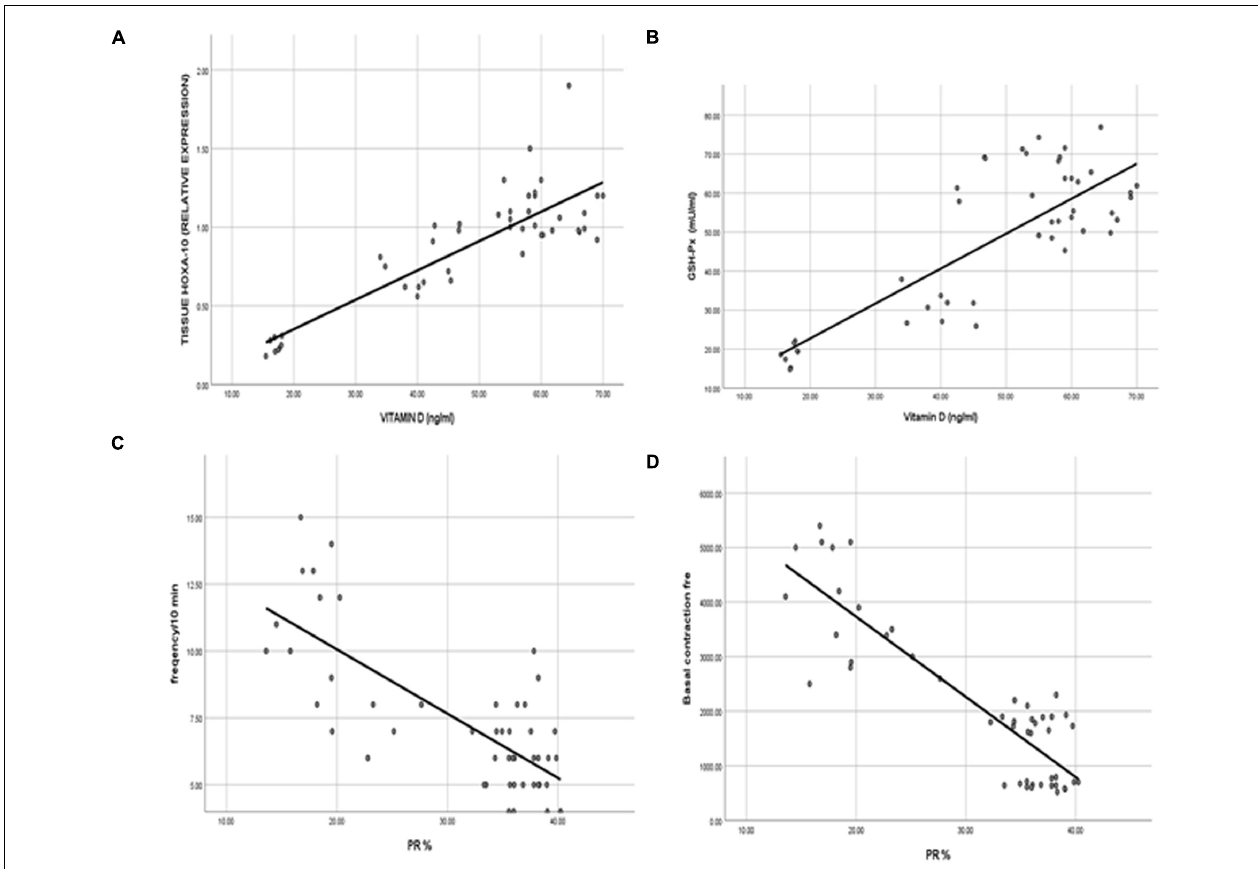
FIGURE 10 | Representation of strong positive correlations between the VD levels and (A) HOXA-10 and (B) GSH-Px. Interestingly, the uterine contractility represented by (C) the contraction wave amplitude and (D) the frequency of contractions was negatively correlated to VD